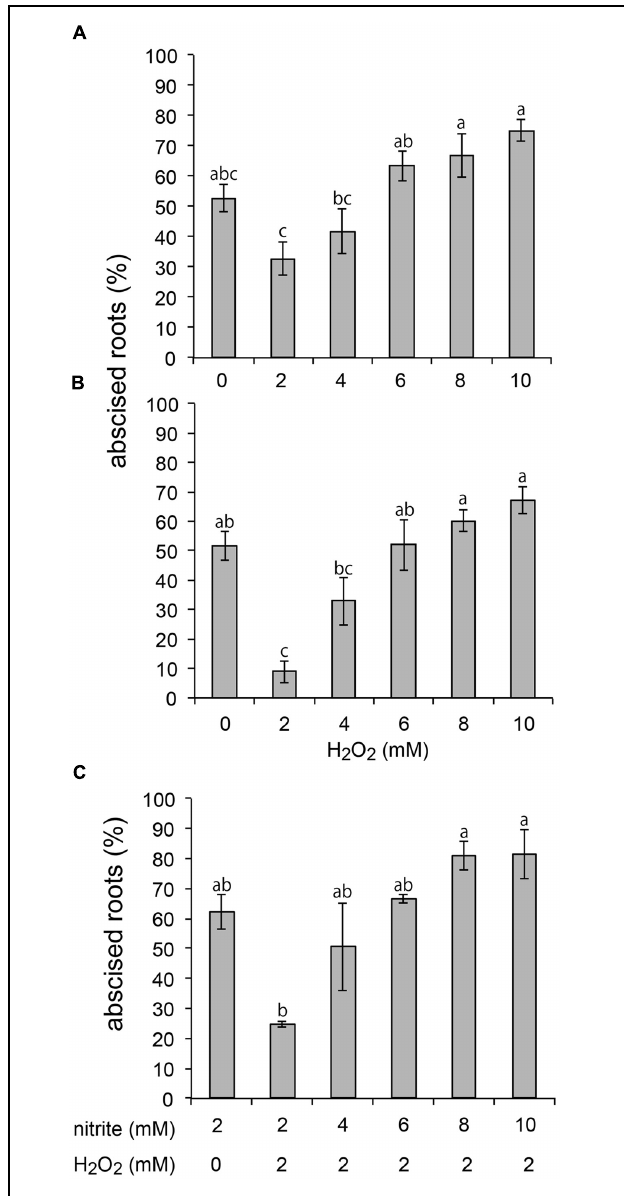
FIGURE 1 | Combined effect of nitrite and H 2 O 2 on root abscission of Azolla pinnata plants. Abscission was measured 90 min after 2 mM